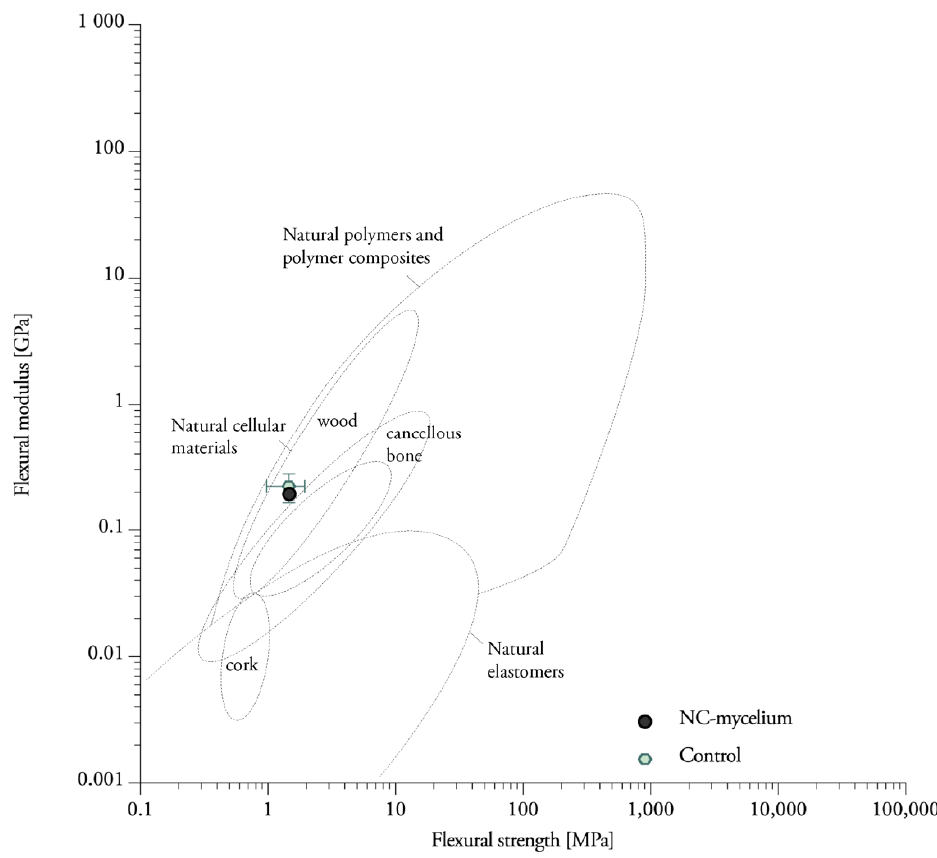
Figure 9. A material property, plotting Young’s modulus against strength for nanoclay–mycelium composites on an Ashby chart for natural materials.